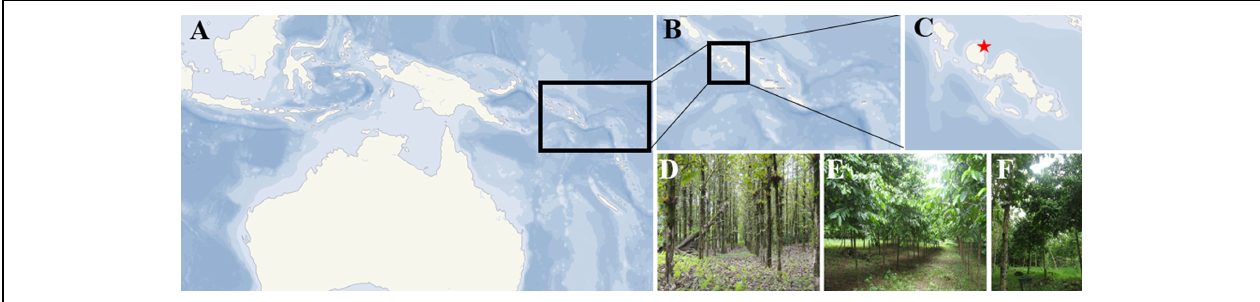
FIGURE 1 | Smallholder tree plantation systems in Solomon Islands. The field site is located within the Pacific region (A) , in Solomon Islands (B) , at Kolombangara, Western Province (C) , where teak (D) , flueggea (E) , and mixed-species (F) plantations were established in 2009.